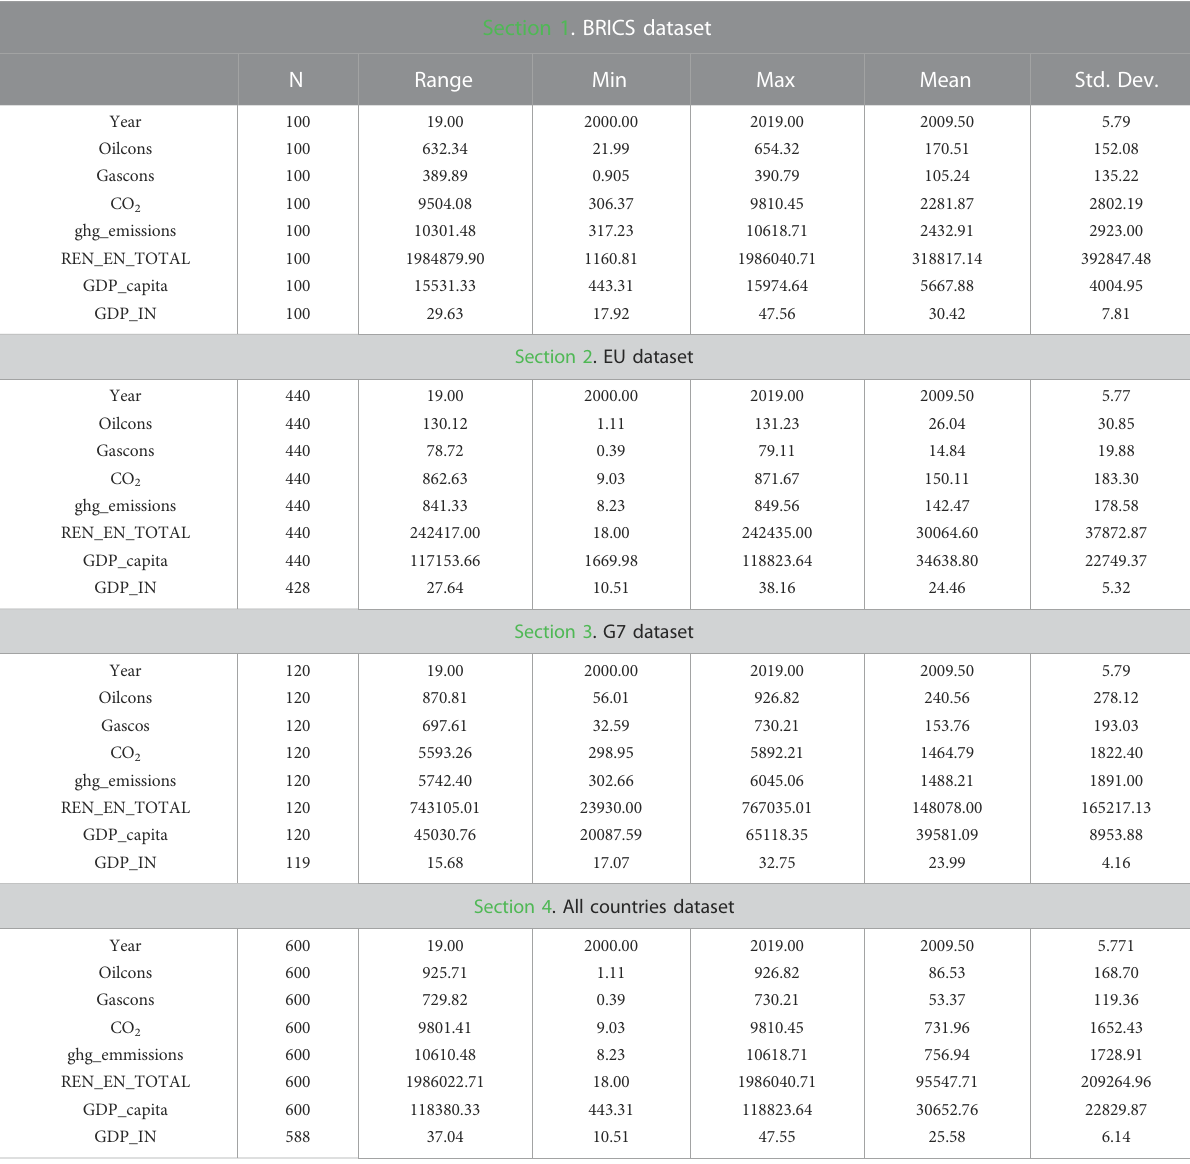
Section 1. BRICS